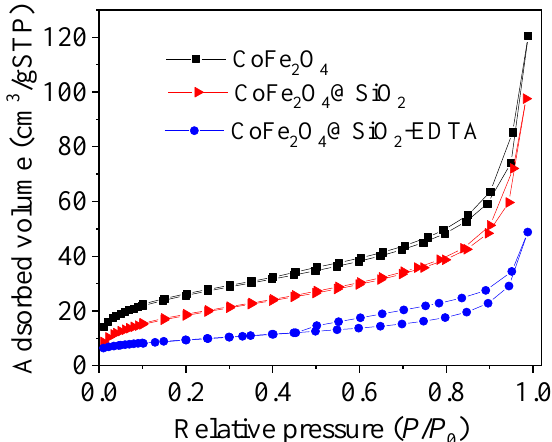
Figure 6. N 2 adsorption desorption isotherms.